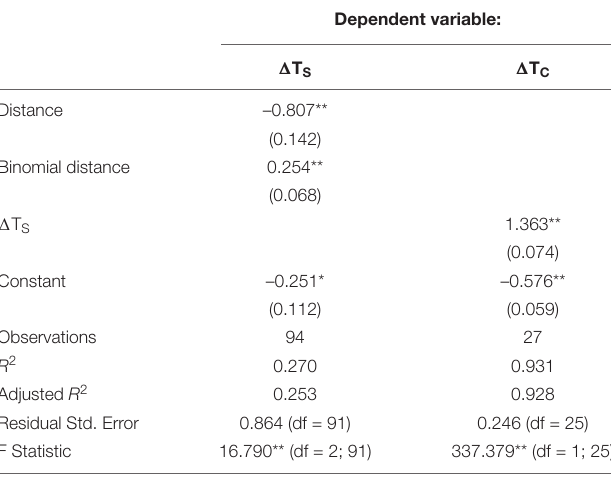
TABLE 2 | Results of polynomial regression between distance and (cid:49) T S ; and linear regression between (cid:49) T S and (cid:49) T C . Dependent